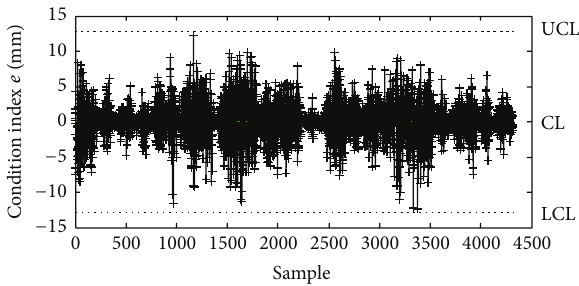
Figure 19: Mean value control chart for longitudinal displacements of piers.